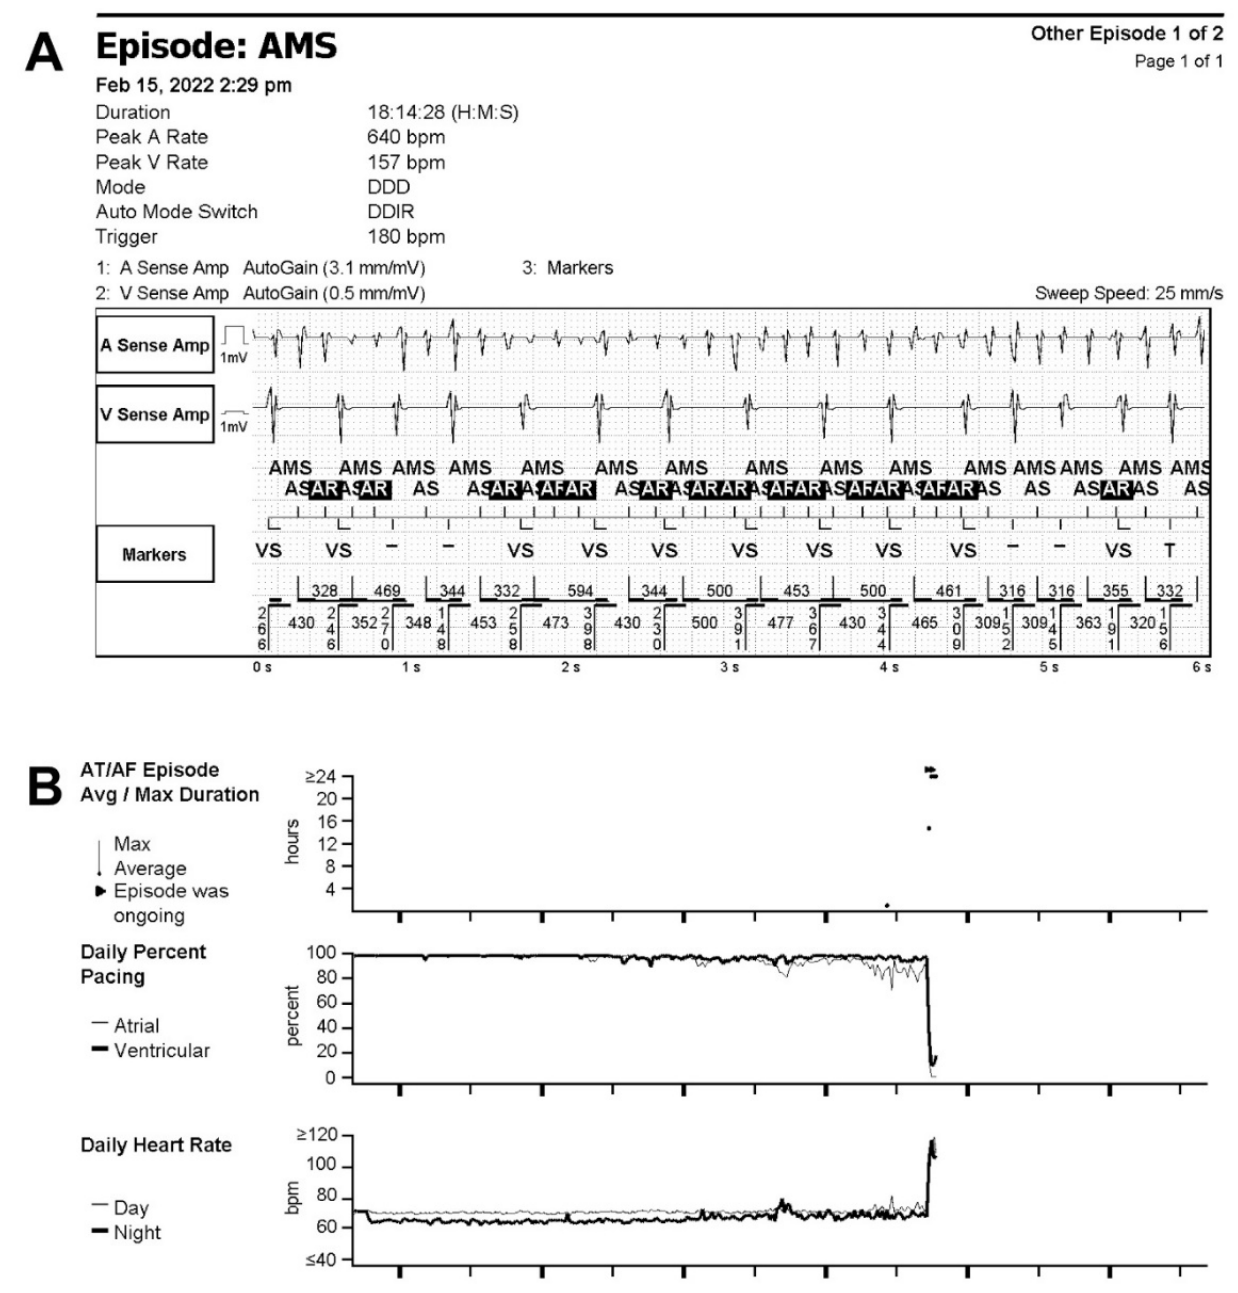
Figure 1. Remote diagnostics of atrial fibrillation via smartphone app: ( A ) Intracardiac electrogram of silent AF episode recorded by cardiac resynchronization therapy defibrillator and sent via Bluetooth smartphone app remote monitoring (RM) on 16 February 2022; ( B ) Diagnostics trends sent via RM presenting correlation between onset of AT/AF episode and significant drop in resynchronization therapy (Daily Percent Pacing) and increase in daily heart rate. AMS, auto mode switch.